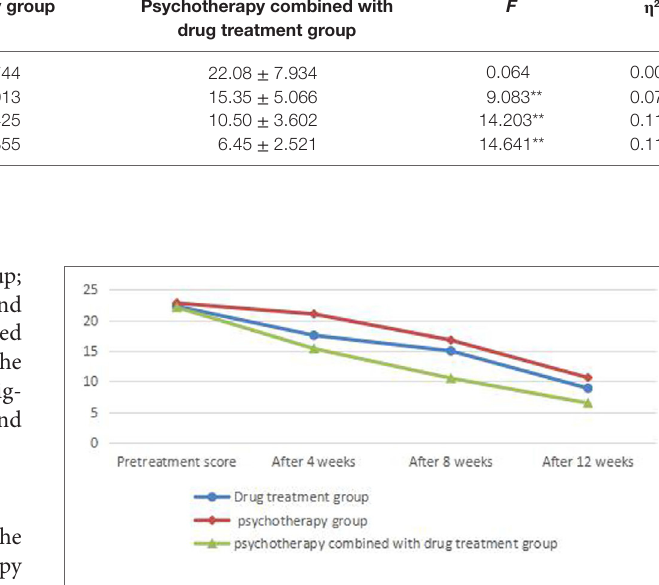
FigUre 3 | Comparison of symptom scores before and after treatment of patients in each